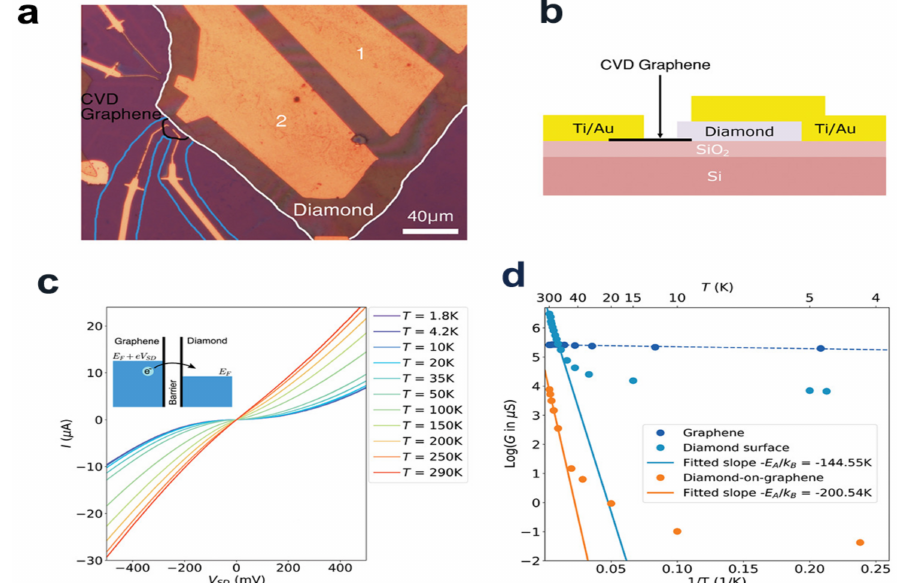
Figure 12. ( a ) Optical properties of a diamond-on-graphene heterojunction (evaporated contacts tagged via a blue line, the CVD graphene islands tagged via a black line, and the diamond nanosheet tagged via a white line). The data indicate the diamond-on-graphene heterojunction, diamond sample and graphene sample. ( b ) lateral view, sketch map of sample. Upper left illustrations: Tunneling behavior of heterojunction at low-temperature and low-bias voltage. ( c ) Temperature-dependent I–V trait of diamond heterostructures on graphene. The blue line is used to represent the cutting area of graphene island, which avoids cross current via etching a tiny zone. ( d ) Logarithm of conductance G versus 1/T at the low bias I–V curves (to make it easy to read, including the top axis of T in K). In nitrogen and hydrogen-mixed gases, nitrogen-doped ultrananocrystalline dia- mond/hydrogenated amorphous carbon (UNCD/a-C:H) thin membranes are developed using coaxial arc plasma deposition. Within the bias voltages range from − 5 V to +5